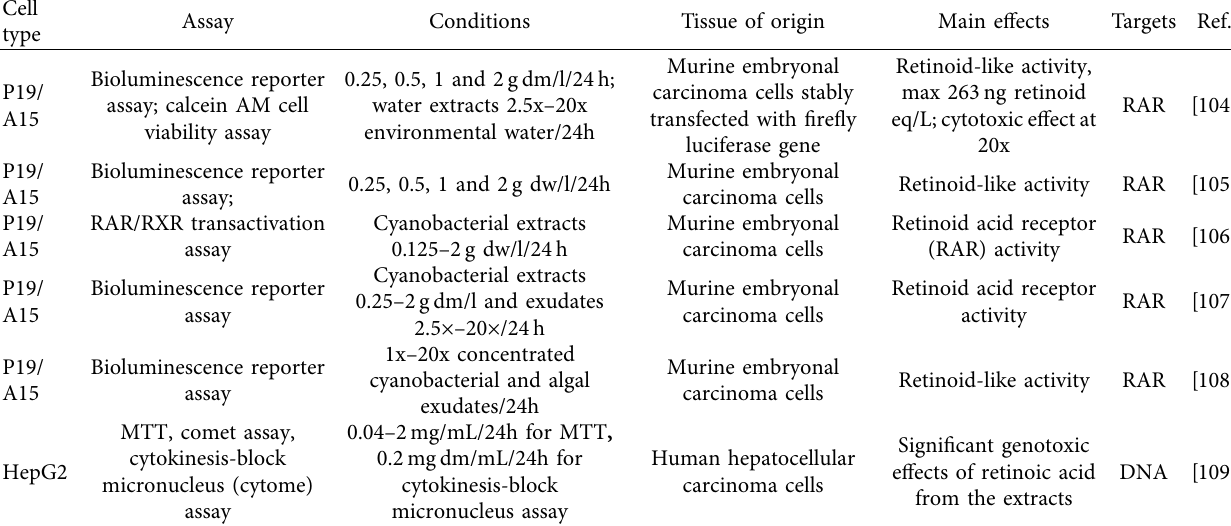
Table 10: Cytotoxicity of cyanobacterial retinoids.